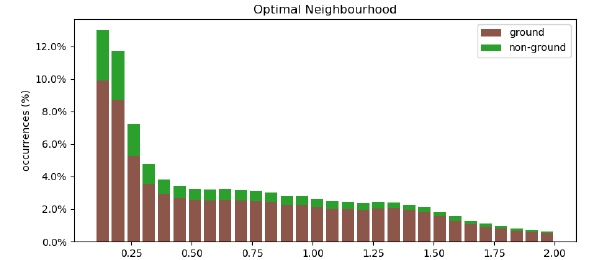
Figure 3. Distribution of radius of the optimal neighbourhood with respect to the manually labelled classes. The points with bigger neighbourhood than 2.0 m (only 3.5% of all) are not shown in the graph.